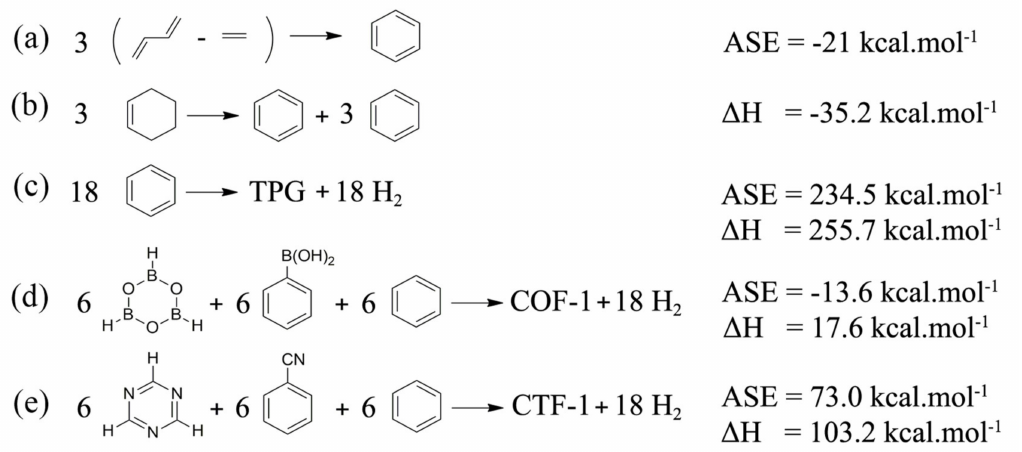
Figure 4. ASE and ∆ H calculations for reference compounds, TPG, COF-1 and CTF-1. ( a , b ) ASE and ∆ H calculations for the formation of benzene, respectively. ( c – e ) ASE and ∆ H calculations for the formation of TPG, COF-1 and CTF-1,